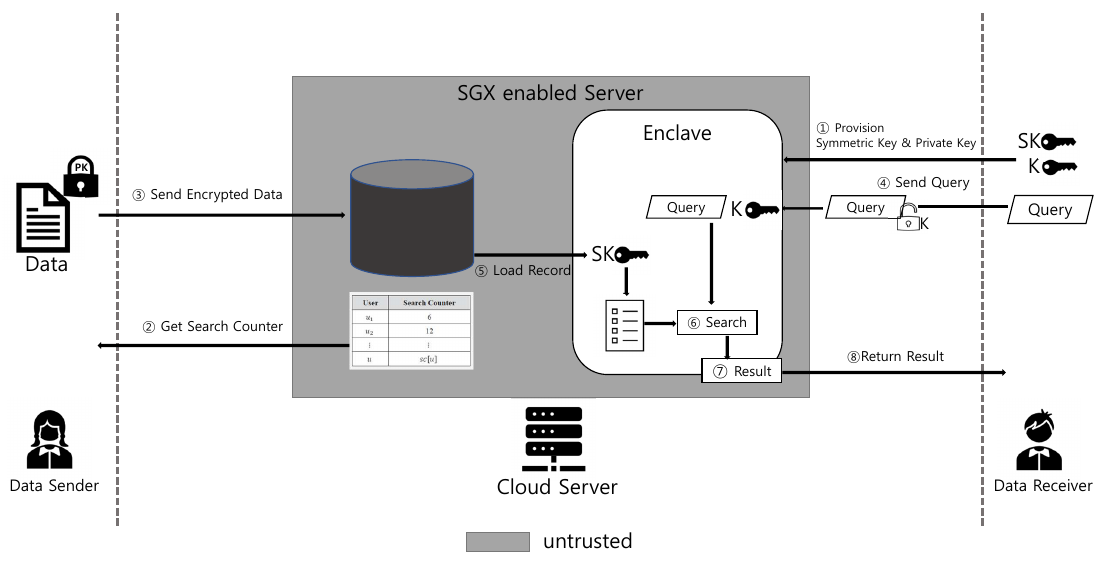
Figure 1. High level design